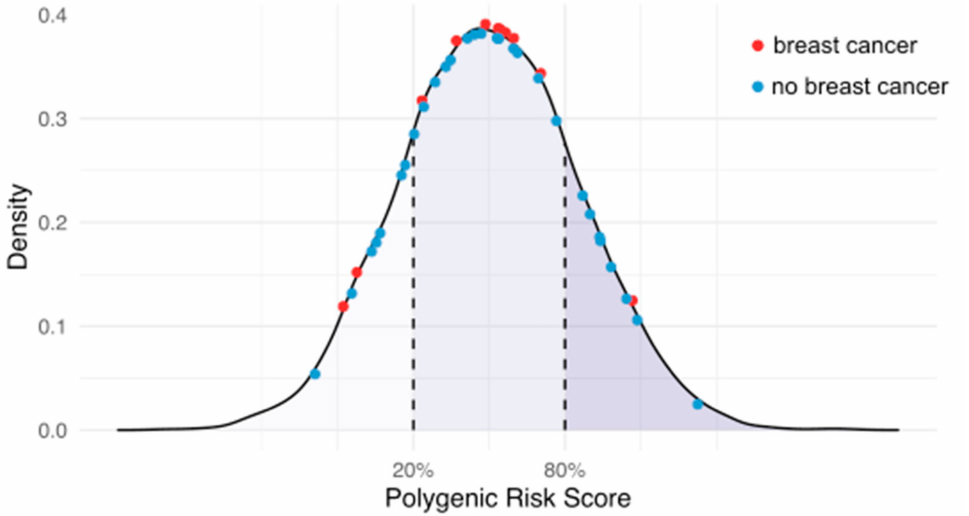
Figure 3. PRS distribution of female pathogenic variant (PV) carriers who were affected (red) or unaffected (blue) by prevalent BC. Density represents the proportion of individuals in each PRS group (low/medium/high). The PRS is distributed normally according to scaled PRS score (mean 0, standard deviation 1). PV carriers are highlighted across the PRS